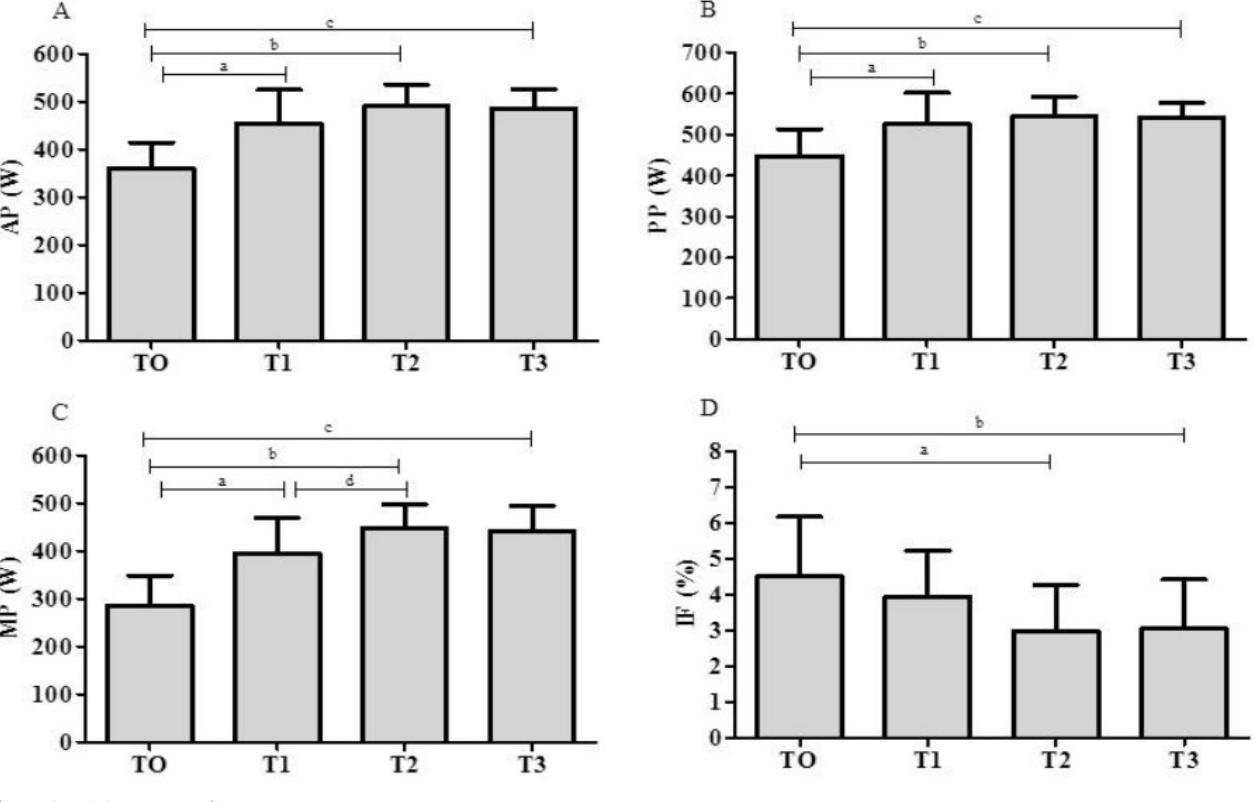
Figure 3. RAST test results.